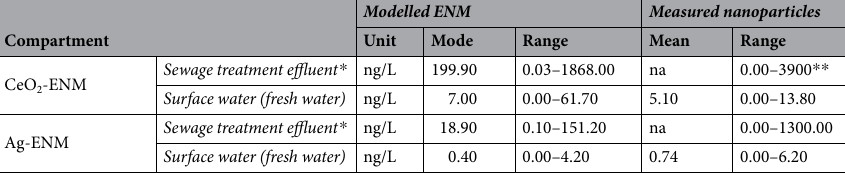
Table 6. Comparison for an early validity discussion of our PECs and nanoparticle concentration measurements, reported elsewhere 73 . We show full ranges with mode or mean values. * Very vague comparison based on measurements for industrial waste water. ** Ce (non cerium dioxid) particles. na: not